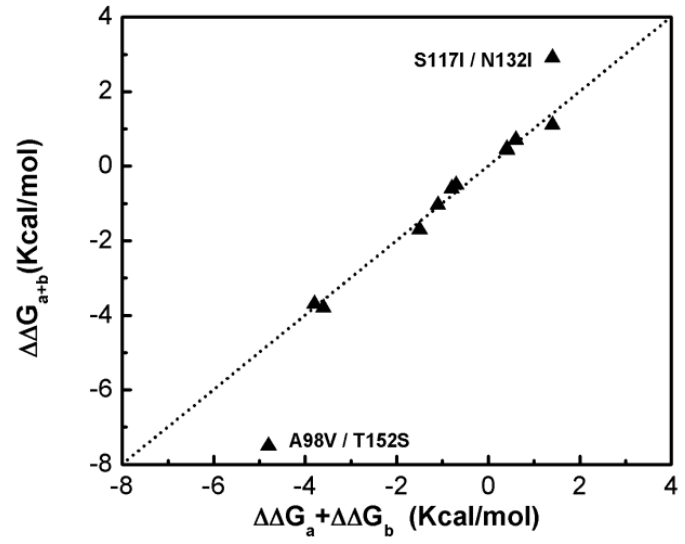
Figure 1. Compare the free energy changes of double-site mutations with that derived by the summation of the two corresponding single-site mutations of the T4 phage lysozyme.